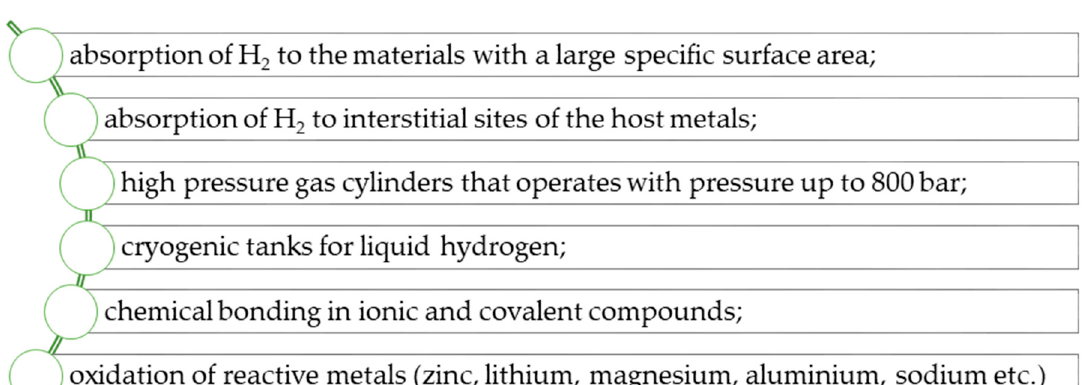
Figure 3. Approaches to store hydrogen (on the basis of [10]).